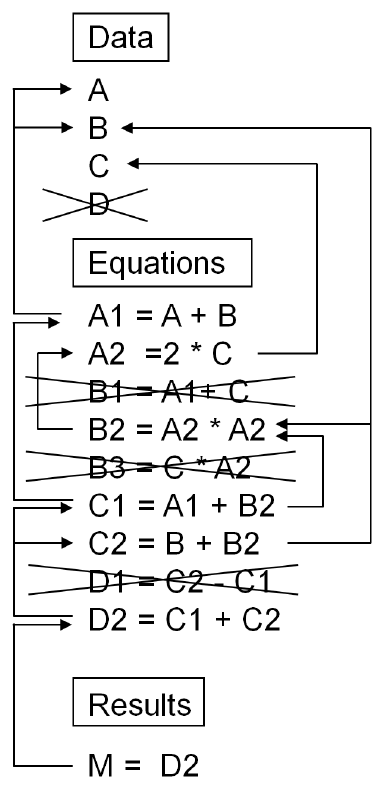
Figure 5. Recursive scheme